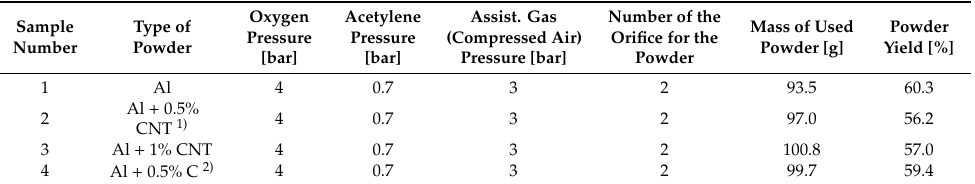
Figure 1. Flame-spraying process: ( a ) a diagram of handheld flame jet burner [40]; ( b ) a photo from trials of flame-spraying aluminum coatings with CastoDyn DS 8000 burner . Table 3. Parameters of flame-sprayed aluminum and aluminum coatings reinforced with carbon materials using CastoDyn DS 8000 torch .